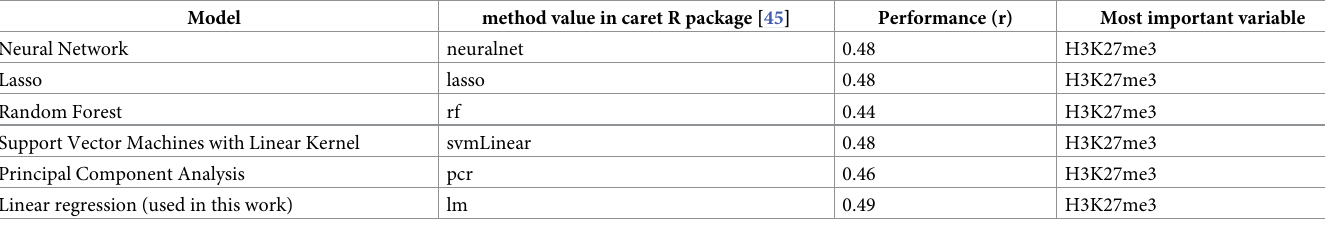
Table 3. Comparative analysis of other methodologies to predict gene expression in the Hi-C-top